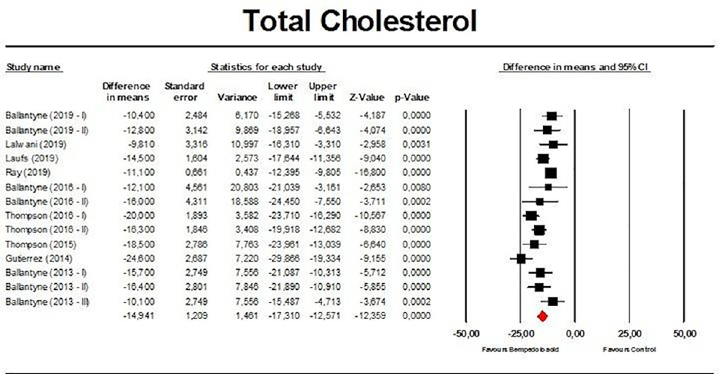
Fig 2. Forest plot displaying mean difference and 95% confidence intervals for the effect of bempedoic acid on plasma levels of total cholesterol.